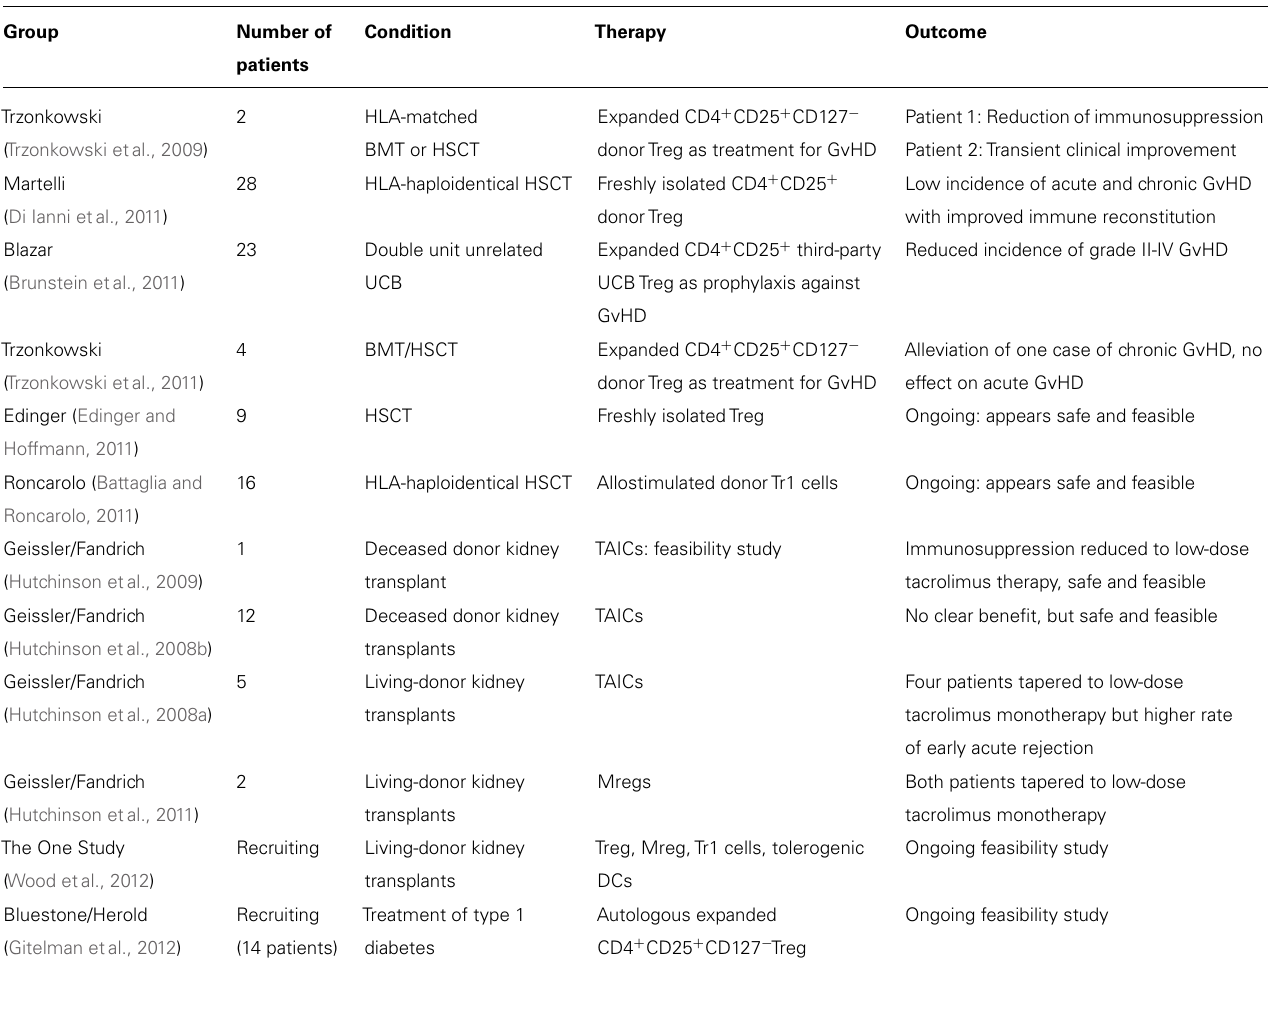
Table 1 | Concluded and ongoing clinical studies using cellular therapy for peripheral regulation.